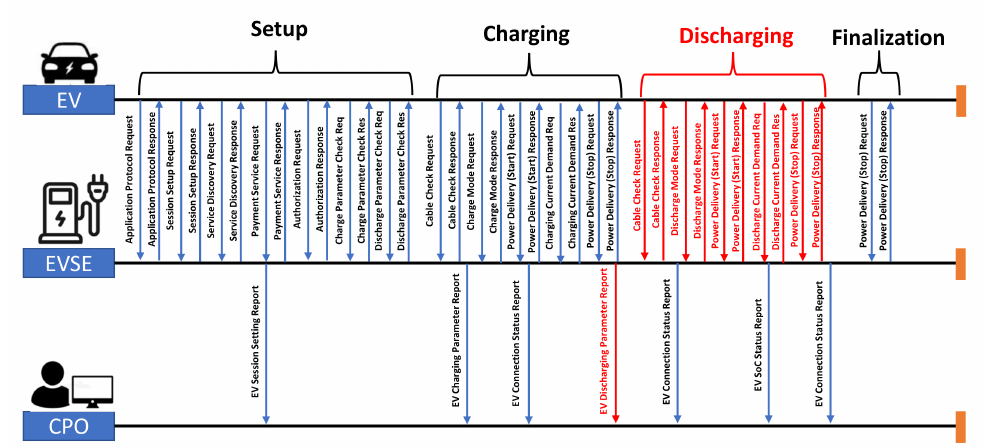
Figure 7. The communication request and response stream during charging/discharging test.